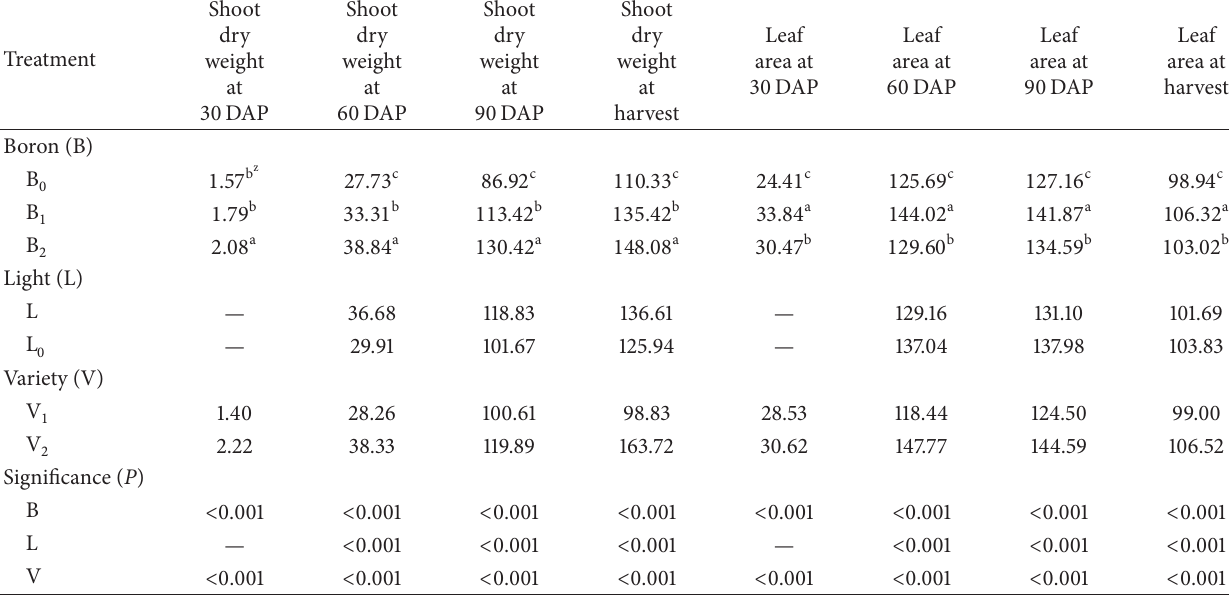
Table 4: Effect of boron and light on shoot dry weight and leaf area in two peanut varieties (mean of two trials).